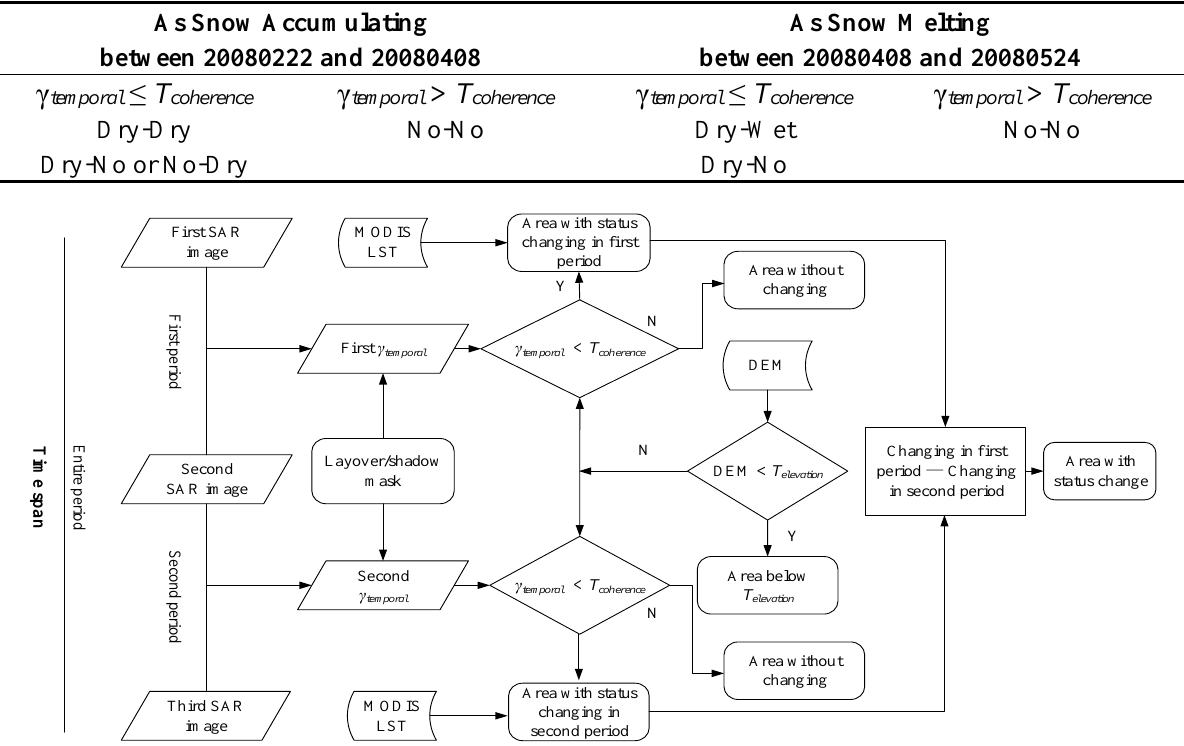
Table 3. γ temporal and changes of snow statuses. T coherence is the threshold to delineate the areas with or without snow changes.